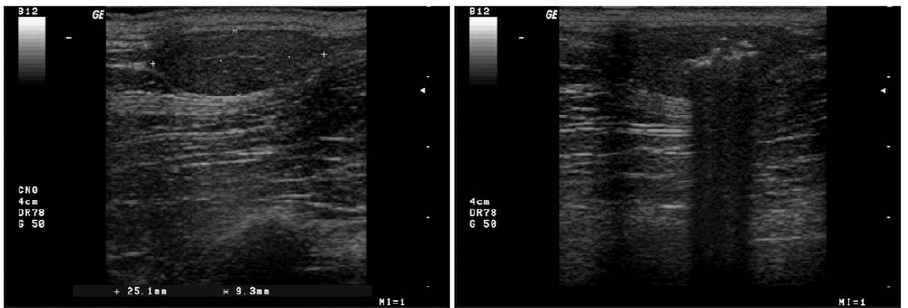
Figure 1. Ultrasound images of an untreated and a treated lipoma. A - An oval sub-fascial lipoma in the right axillary region. A well defined hyperechoic capsule is visible; a hypoechoic homogeneous echostructure interrupted by thin stripes is observed. B – The lipoma after infiltration of the steroid solution.